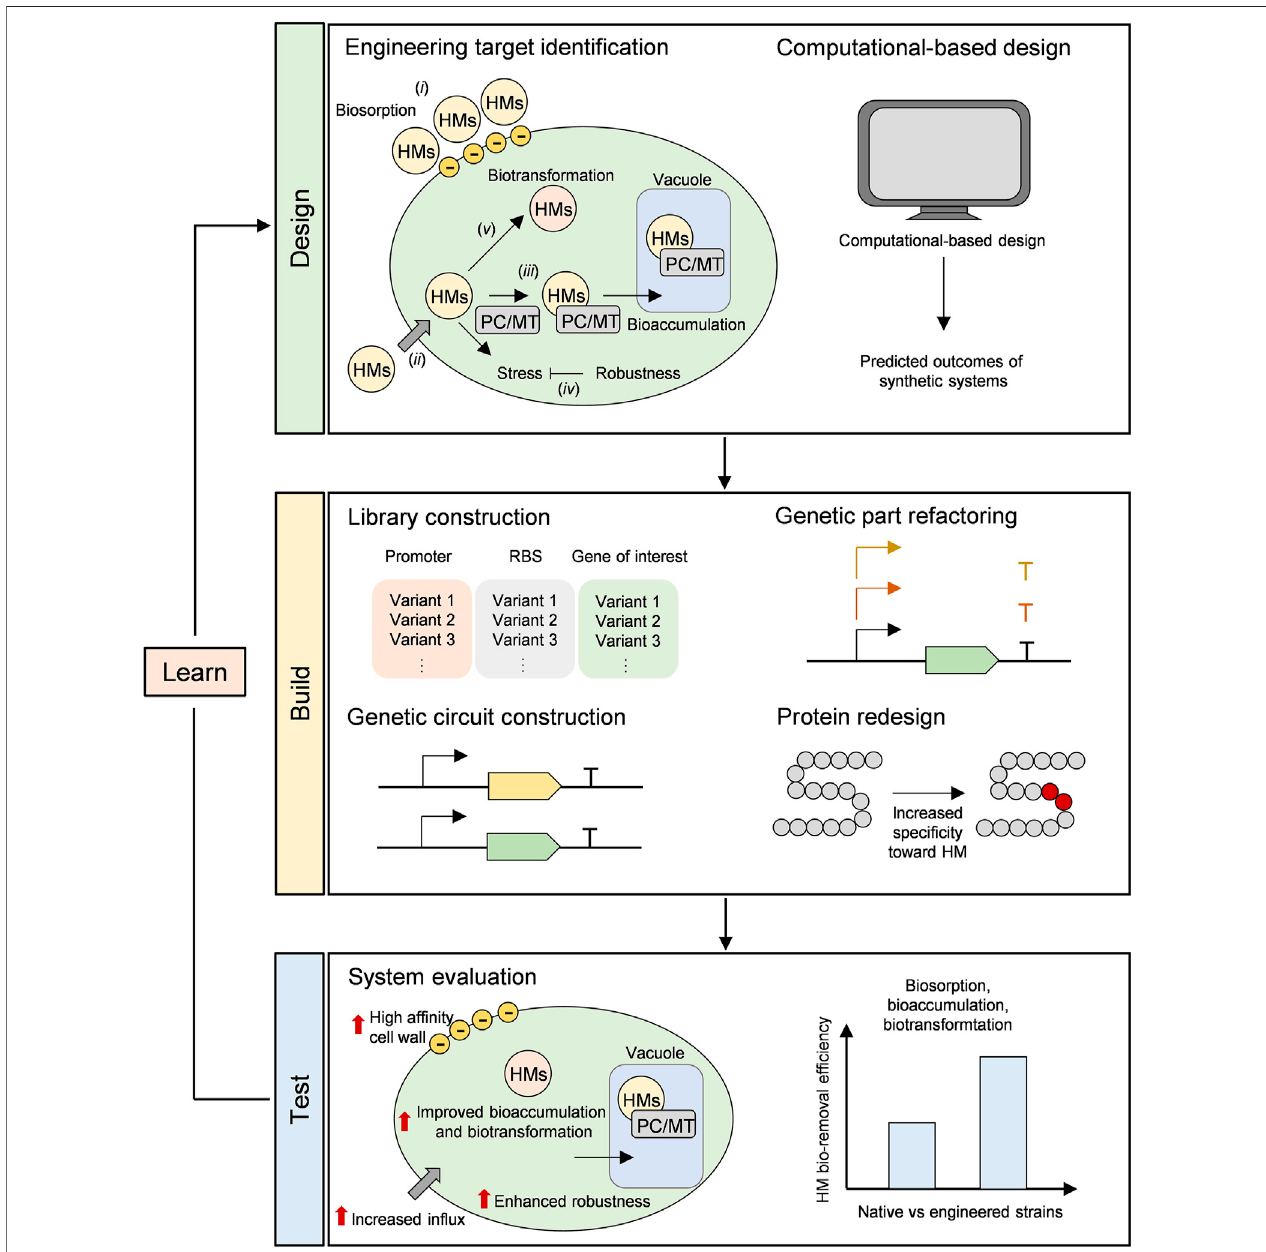
FIGURE1| Design-Build-Test-Learn(DBTL)cycleofsyntheticbiologyforHMbio-removal.Design:( i )Biosorption( ii )CellularuptakeofHMs( iii )Bioaccumulation( iv ) Native cellular responses to HM-induced stress ( v ) Biotransformation.